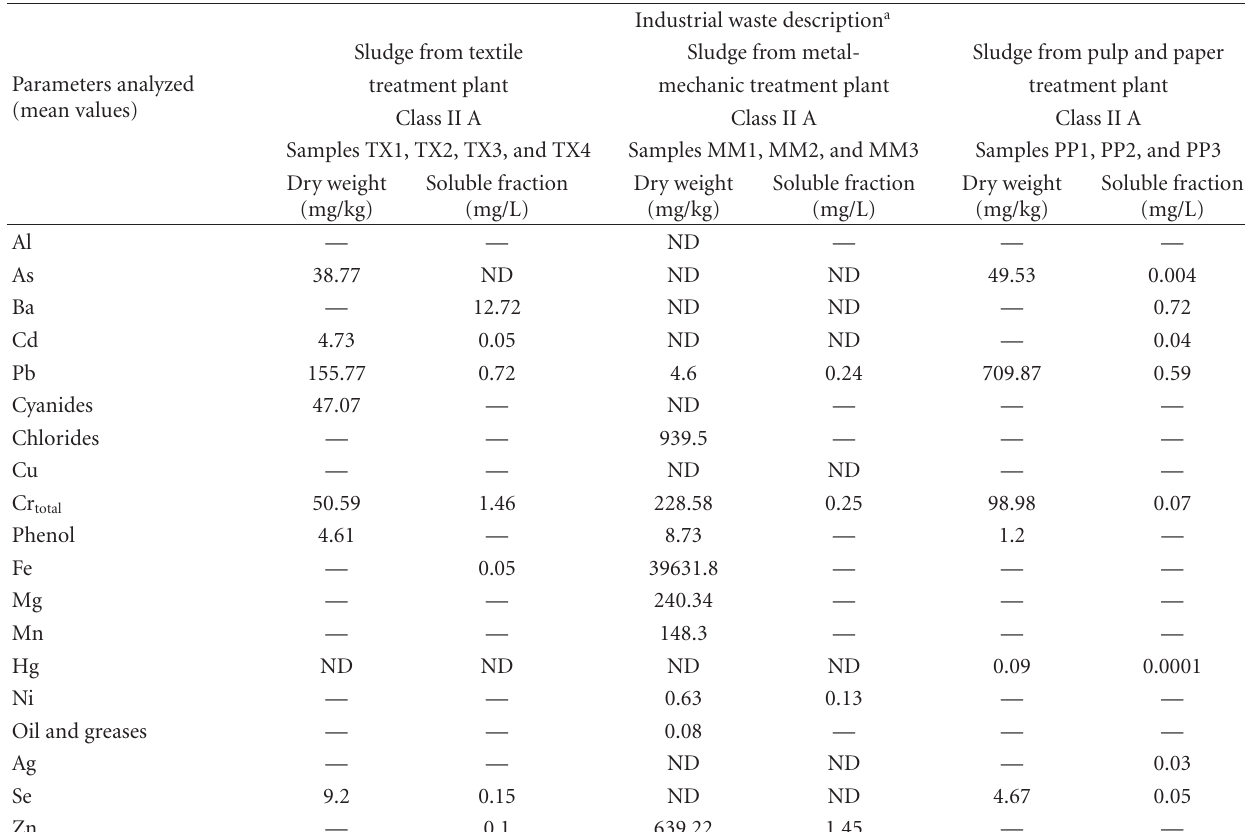
Table 1: Characteristics of industrial solid waste samples collected at the entrance of an industrial an sanitary landfill, as classified according to NBR 10004 (ABNT,